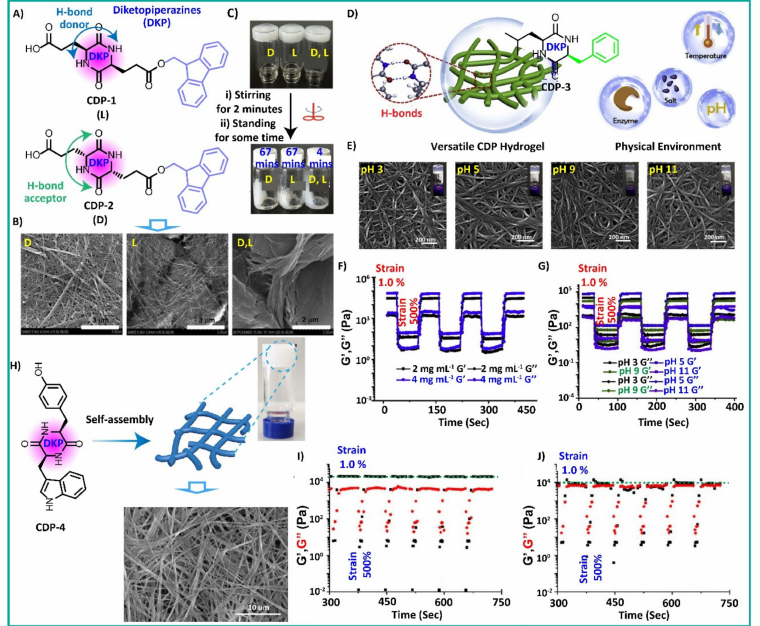
Figure 8. ( A ) Molecular structure. ( B ) FE-SEM images. ( C ) Vial containing hydrogel photographs